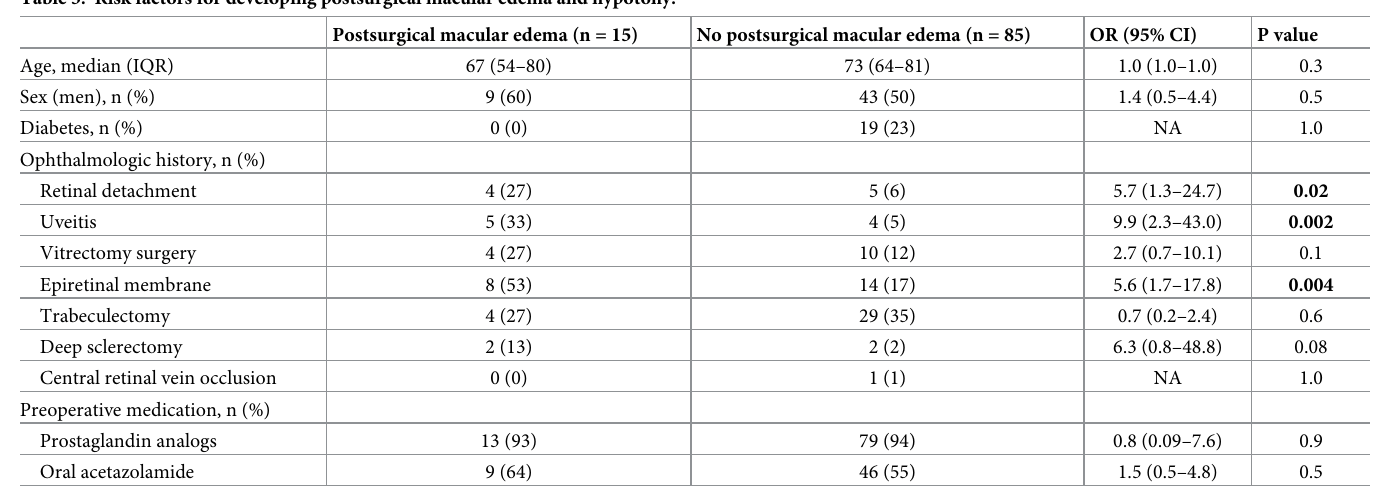
Table 3. Risk factors for developing postsurgical macular edema and